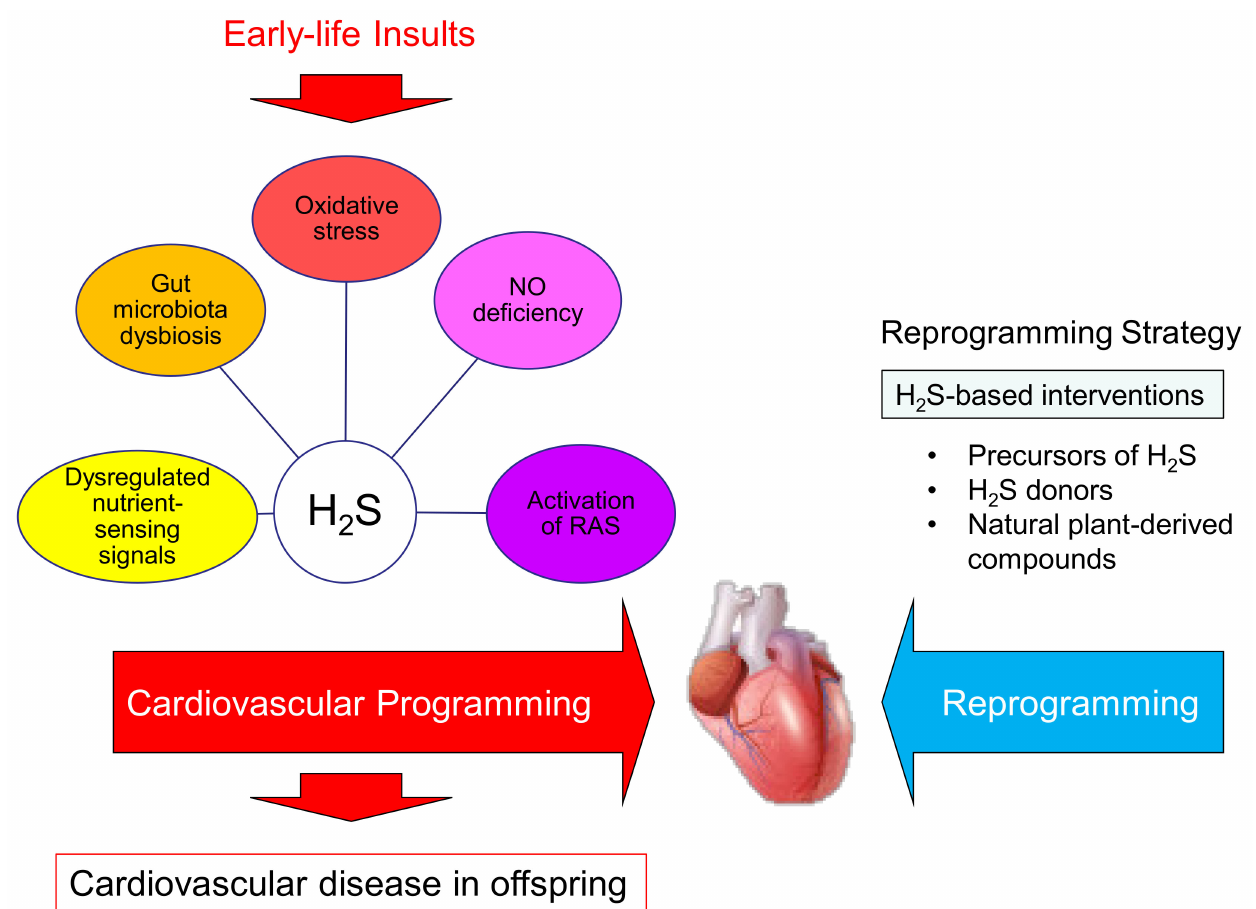
Figure 3. Schema outlining the cardiovascular programming versus reprogramming interventions. Maternal insults can induce cardiovascular programming, consequently leading to cardiovascular disease in adulthood. Hydrogen sulfide (H 2 S) interconnects with other mechanisms and plays a key role in the pathogenesis of cardiovascular programming. These mechanisms include oxidative stress, nitric oxide (NO) deficiency, activation of the renin–angiotensin system (RAS), dysregulated nutrient-sensing signals, and gut microbiota dysbiosis. Conversely, early H 2 S-based interventions may reverse or delay programmed processes to prevent cardiovascular disease of developmental origins by so-called